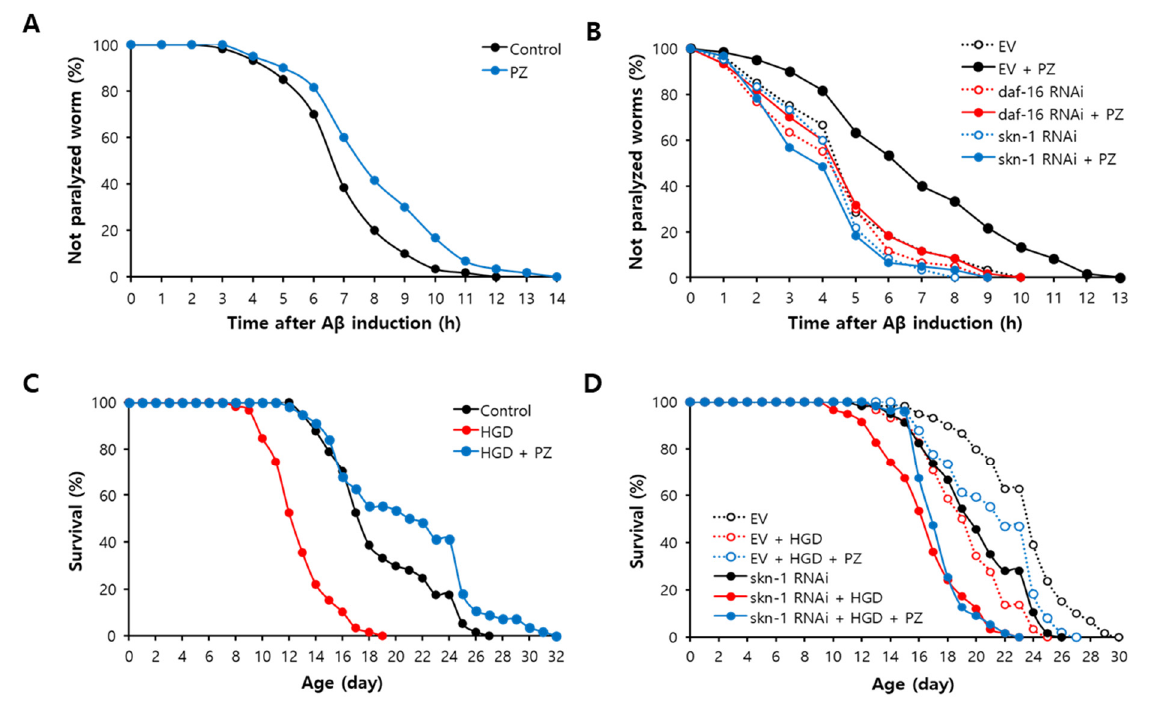
Figure 5. Effects of phlorizin on disease models of Alzheimer’s disease and diabetes mellitus. ( A ) Number of paralyzed worms after induction of A β transgene was counted every hour until all worms were paralyzed. ( B ) Effects of phlorizin on paralysis caused by A β were compared between control with EV RNAi and worms with daf-16 or skn-1 RNAi. ( C ) Survivals of worms were monitored for untreated control, HGD-treated group, and both HGD and phlorizin-treated group. ( D ) Role of SKN-1 in inhibitory effect of phlorizin on HGD-induced toxicity was examined using genetic knockdown of skn-1 . PZ, phlorizin (10 μ M); EV, empty vector; HGD, high-glucose diet (40 mM glucose).